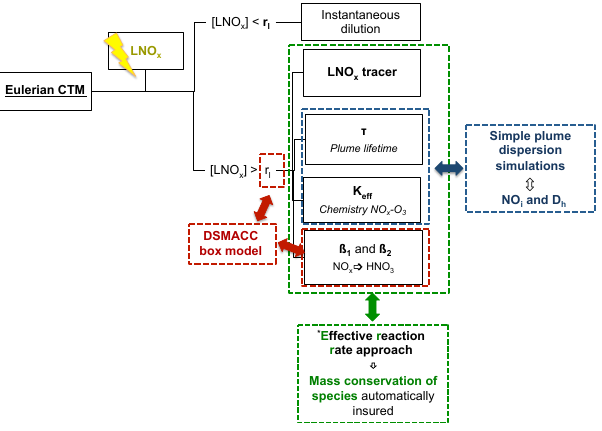
Figure 1. Diagram of the lightning NO x plume parameterization based on the effective reaction rate approach. The arrows link the parameters to their estimate approach. The red boxes are for the pa- rameters estimated with the DSMACC model and the blue boxes are related to the parameters calculated with the simple plume dis- persion model. Finally, the green boxes show the effective reaction rate approach in the GEOS-Chem